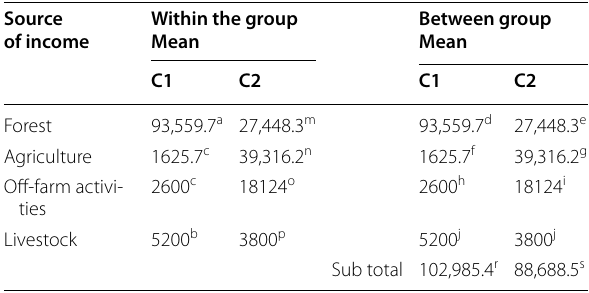
Mean comparison with Tukey HSD, procedure the superscripted letters from ‘a’ to ‘c’ and ‘m’ to ‘p’ indicated the mean (vertical) difference within the group but letters ‘d’ with ‘e’, ‘f’ with ‘g’, ‘h’ with ‘i’ and ‘r’ with ‘s’ specified the mean comparison, between across the category(horizontal), and the same alphabetical letters indicated no significant difference between the mean, however, different letters indicated a significant difference between the mean at 5% significant